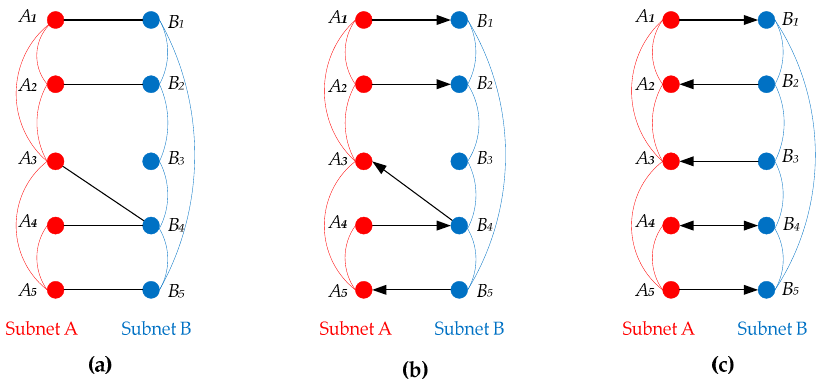
Figure 1. Various interdependent networks models [43]. ( a ) Model with undirected and feedback dependency links; ( b ) Model with directed and feedback dependency links; ( c ) Model with directed and no-feedback dependency links. In sub-graph ( a ); node A 3 and B 4 depend on each other, same as node B 4 and A 4 ; in sub-graph ( b ); node A 4 depend on B 4 , and B 4 depend on A 3 . Both of them form a feedback dependency relationship.